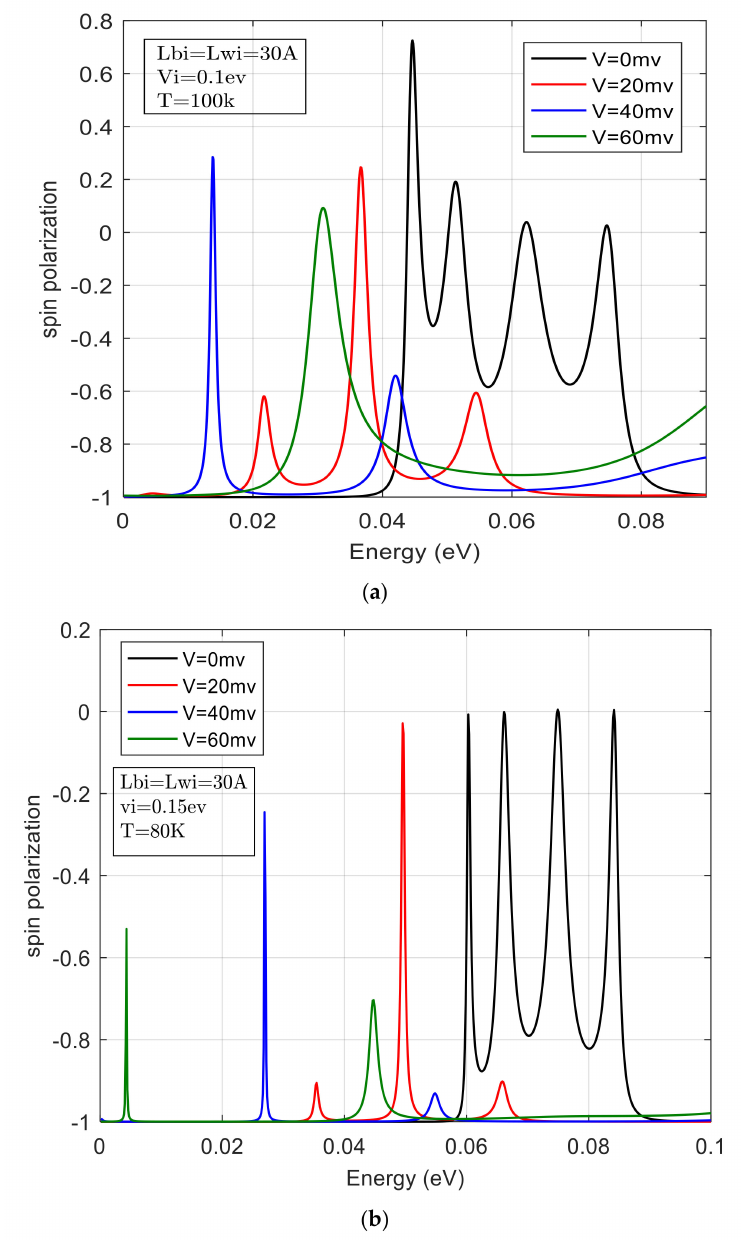
Figure 11. ( a ): Spin-polarization as a function of incident energy for different applied bias voltages (N = 5 and T = 100 K). ( b ): Spin-polarization as a function of incident energy for different applied bias voltages (N = 5 and T = 80